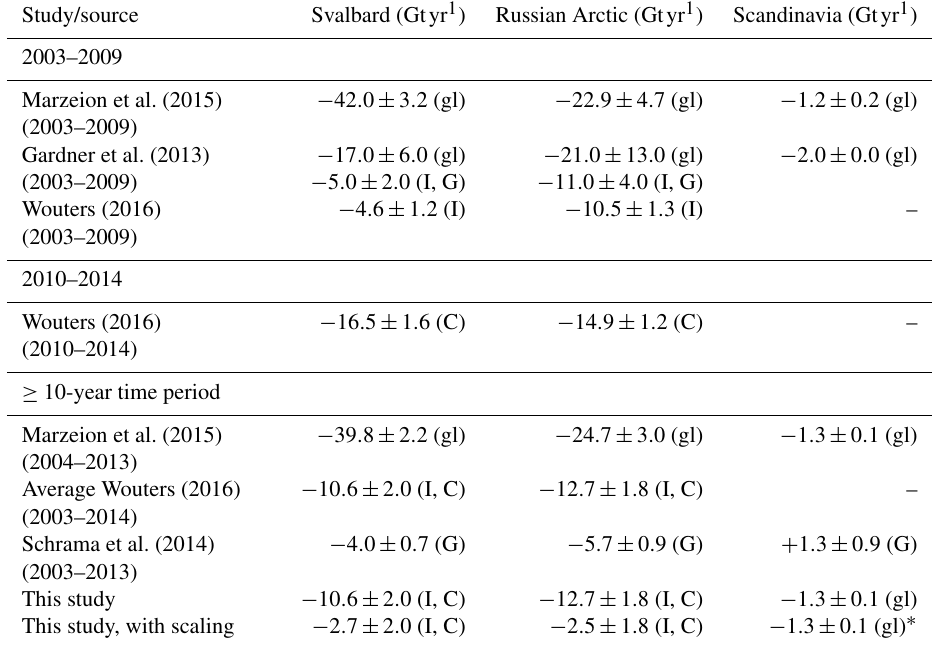
Table 1. Estimates of present-day mass change for Svalbard, the Russian Arctic, and Scandinavia for different time periods and from different sources. Letters in parentheses indicate estimation method: gl – glaciological; I – IceSat; G – GRACE; C – CryoSat. All rates are in Gtyr − 1